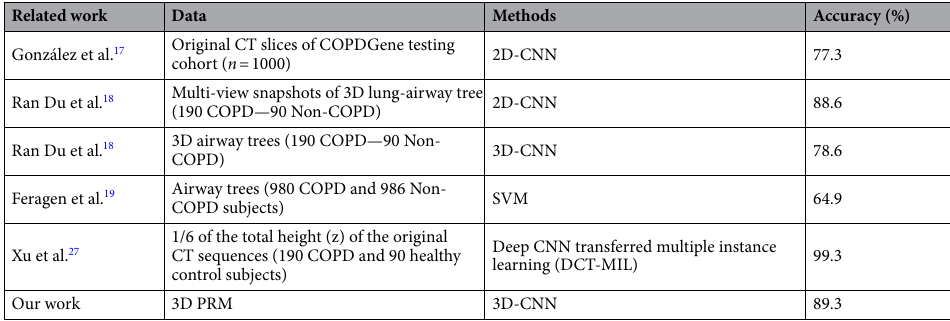
Table 3. Previously published classification results of COPD versus non-COPD